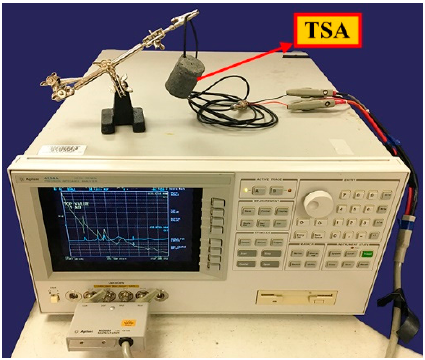
Figure 5. The experimental setup for impedance analysis.